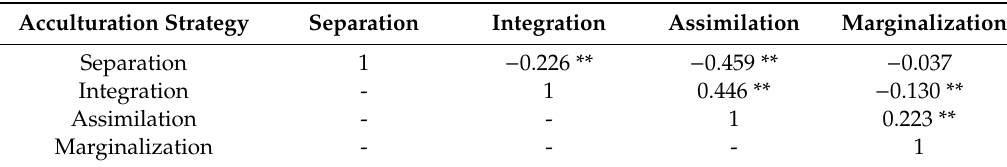
Table 2. Correlation between each of the acculturation strategies.